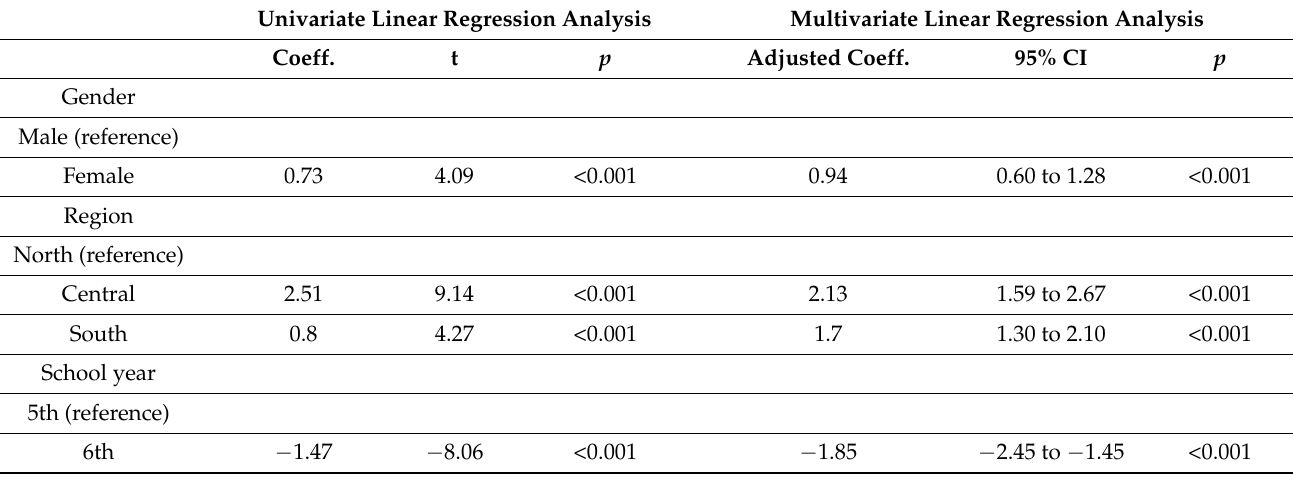
Table 3. Predictors of HCV knowledge scores (n =